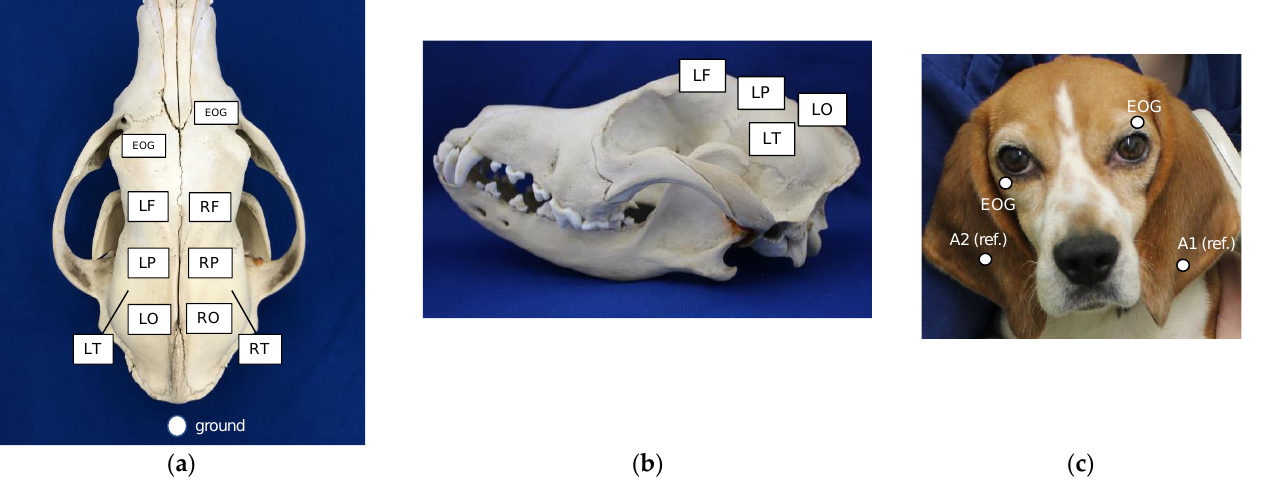
Figure 1. Electrode placement from dorsal ( a ) and lateral ( b ) views of the cranium and frontal view of a dog’s face ( c ). Recording electrodes were placed subcutaneously on both sides symmetrically over the frontal (LF, RF), parietal (LP, RP), occipital (LO, RO), and temporal (LT, RT) lobes. Reference electrodes were placed on the left and right ears (A1, A2). A ground electrode was placed subcutaneously on the dorsal of the neck above the atlas. Electrodes for recording eye movement were placed near the left and right eyelids (EOG).